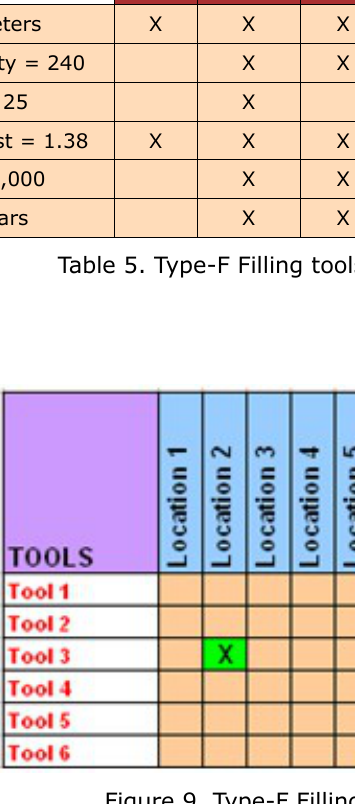
Figure 9. Type-F Filling Tools Allocation